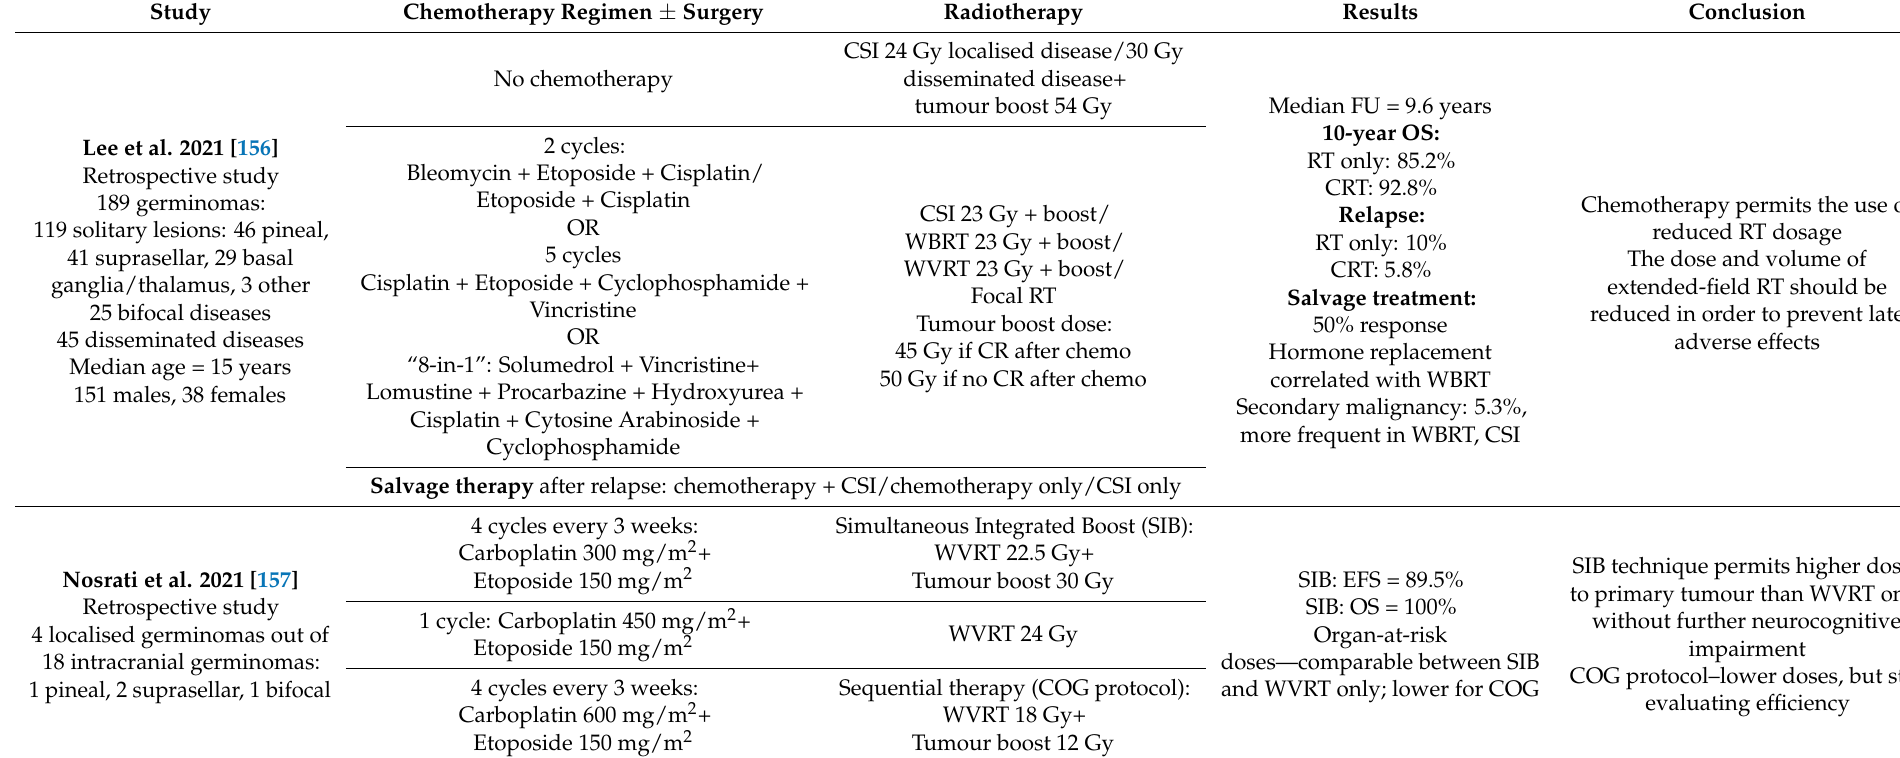
Table A1. Retrospective studies regarding treatment regimes in CNS